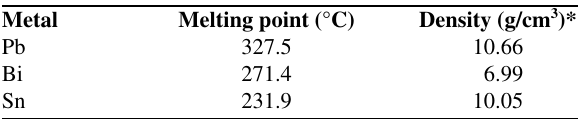
Table 1. Melting points and densities of the three metals used as a positive electrode.